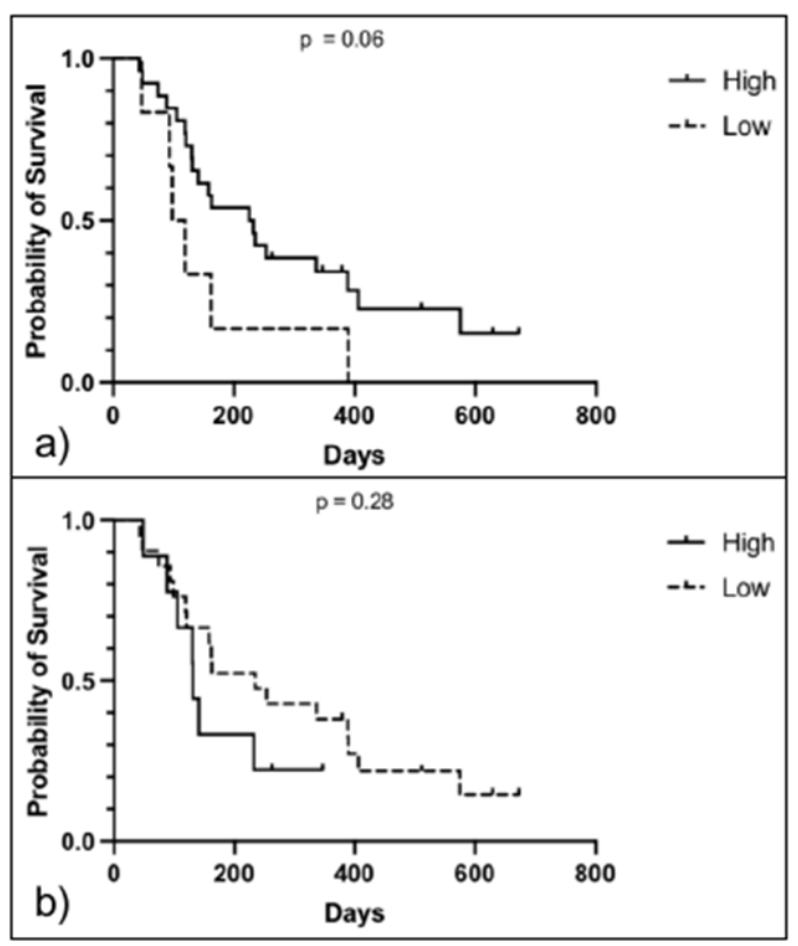
Figure 5. Kaplan–Meier survival analysis of all canine OS with high and low IFG2R expression. ( a ) Survival analysis of dogs with high versus low IGF2R expression on VIS. Survival time did not differ between high (229 days, 95% CI 85–524) and low (108 days, 95% CI 19–118) VIS ( p = 0.06, Log Rank test; n = 25) ( b ) Survival analysis of dogs with high versus low IGF2R expression on CPD score. Survival time did not differ between high (131 days, 95% CI 23–134) and low (235 days, 95% CI 74–433) CPD score ( p = 0.28, Log Rank test; n = 25).